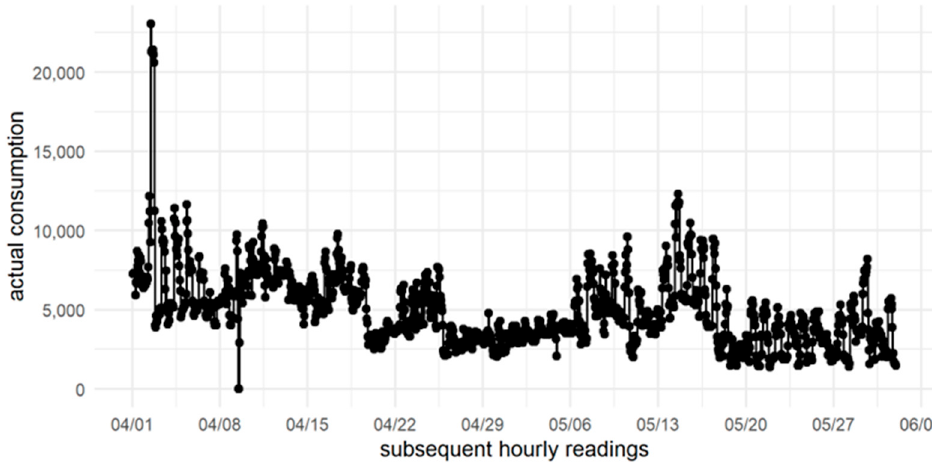
Figure 13. Actual consumption of PPE-Example5. Source: own elaboration.